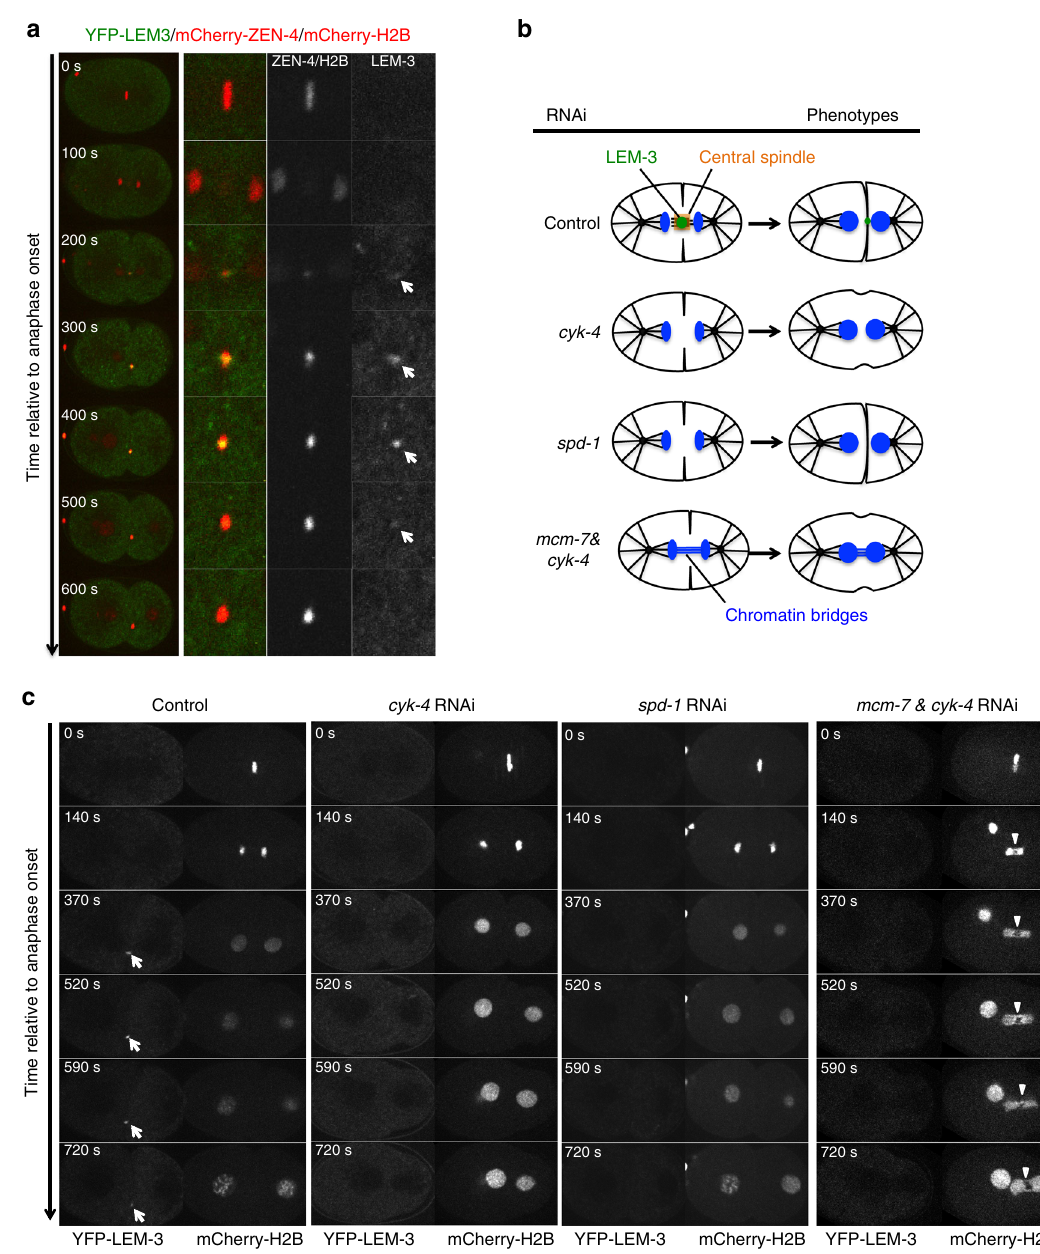
Fig. 2 Central spindle formation is required for midbody localization of LEM-3. a LEM-3 co-localized with the central spindle component ZEN-4. Arrows indicate YFP-LEM-3. b Schematic of LEM-3 localization in control embryos (normal central spindle formation) and cyk-4 , spd-1 RNAi embryos (defective central spindle formation). c Midbody localization of LEM-3 depends on the central spindle component CYK-4 and the microtubule-bundling protein SPD-1. Depletion of the central spindle by cyk-4 RNAi, no LEM-3 foci are detectable even in the presence of chromatin bridges generated by mcm-7 RNAi. Images were taken from a time-lapse recording of the cyk-4 RNAi, spd-1 RNAi, and cyk-4 combined with mcm-7 RNAi-treated embryos expressing YFP-LEM-3 and mCherry-H2B from the anaphase onset of the fi rst mitotic division. Arrowheads indicate chromatin bridges. Times are relative to anaphase